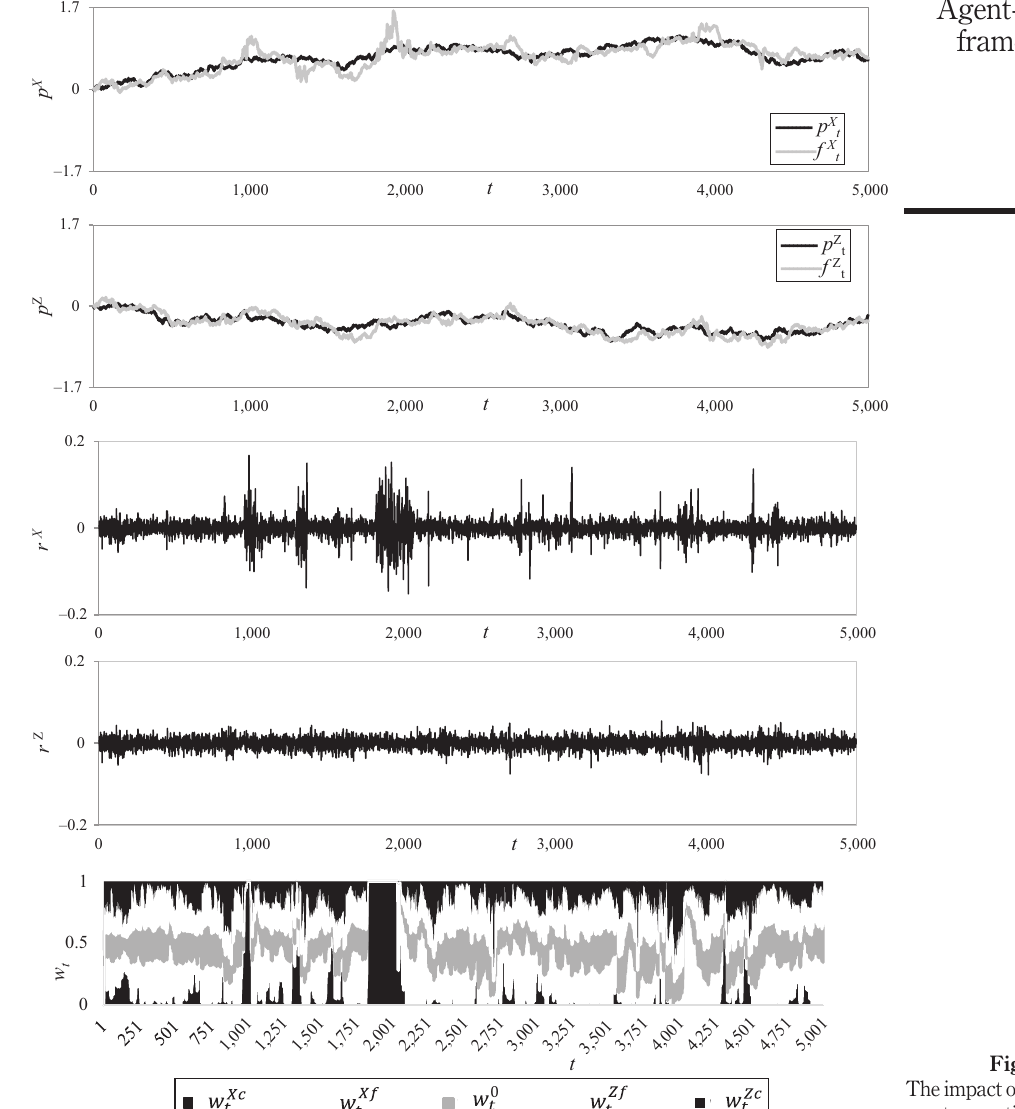
Figure 11. The impact of levying a transaction tax of 0.25 per cent in markets X and Z on both markets ’ log prices, asset returns and the weights of trading